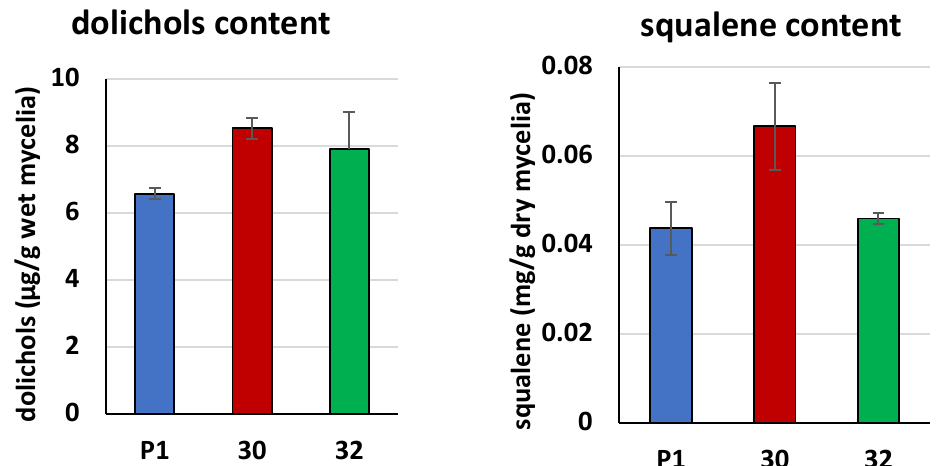
Figure 4. Concentration of dolichols and squalene in the mycelia from RER2 transformed T. atro- viride. Trichoderma strains (30 — RER30/11; 32 — RER32/11) and control strain P1 were processed and analyzed for the concentration of products synthesized by cis -prenyltransferase and squalene synthase, dolichols and squalene, respectively. Data are presented as mean ± standard deviation from three independent experiments, each determined in triplicate. Differences are statistically significant ( p < 0.05; t test).